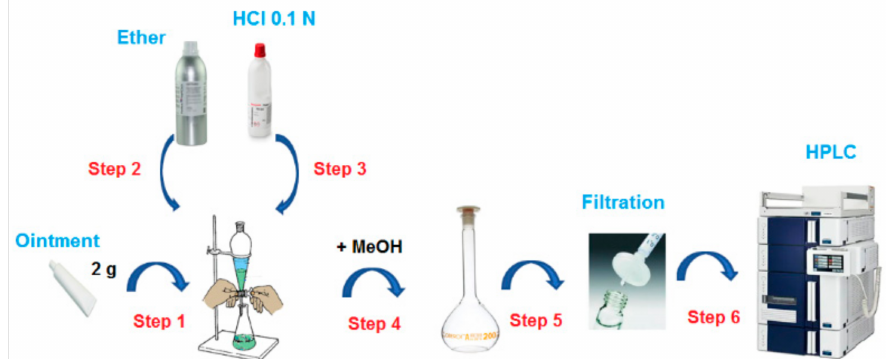
Figure 1. Graphical presentation of the extraction protocol for the nasal